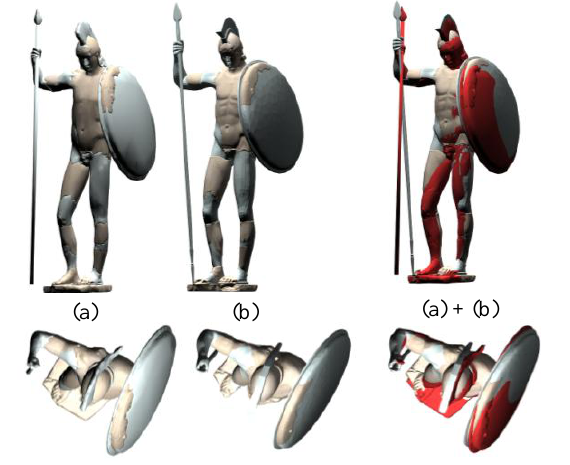
Figure 6. Two different reconstructions of figure G compared.